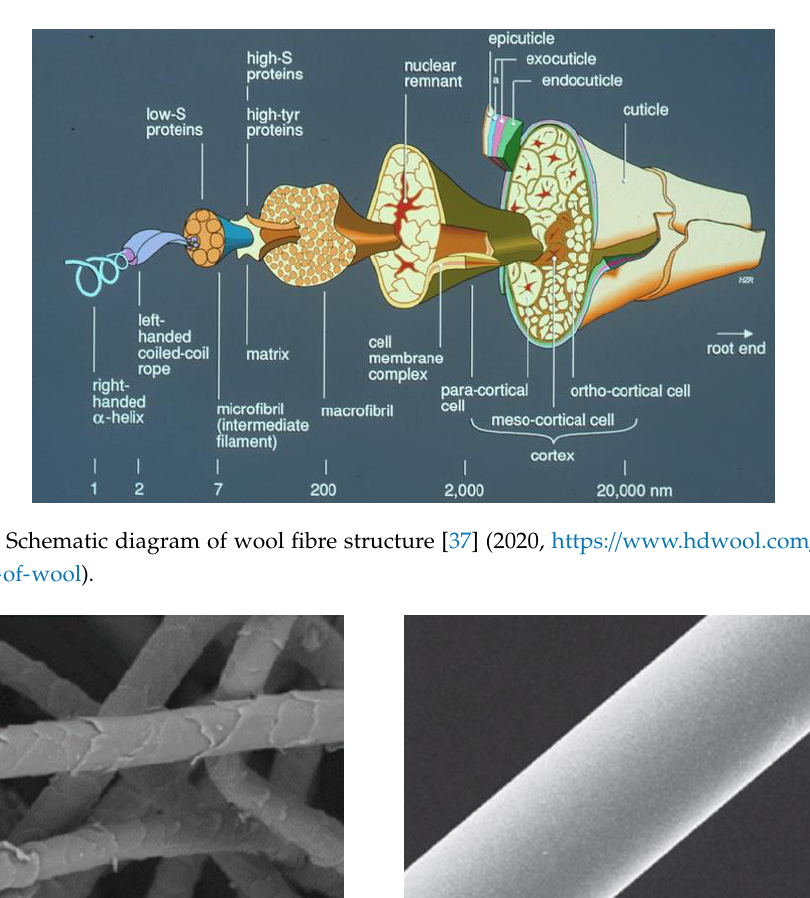
Figure 1. Schematic diagram of wool fibre structure [37] (2020, https://www.hdwool.com/blog/the- structure-of-wool).